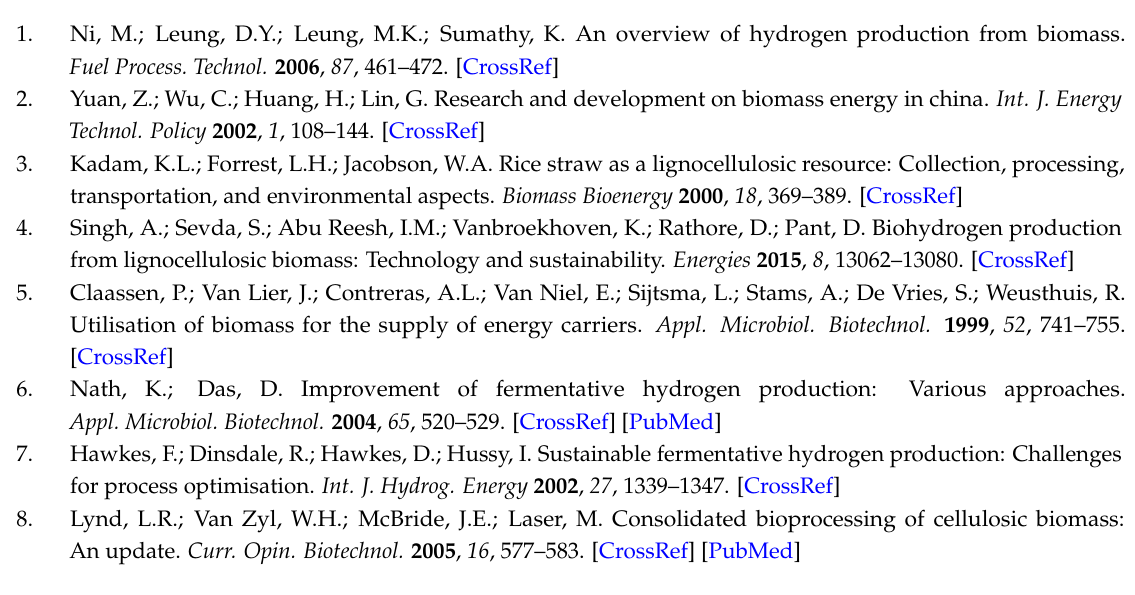
Figure S1. Steps for mechanical treatment. Figure S2. Preparation for steam explosion treatment. Figure S3. Chemical pretreatment. Figure S4. Treated rice straw and sludge in the anaerobic bioreactor. Table S1. Average bio-hydrogen